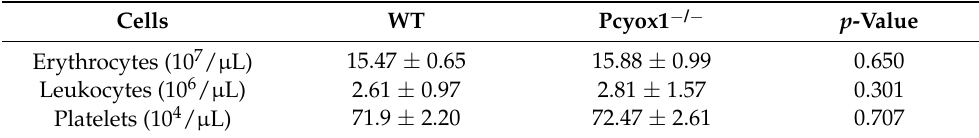
Table 1. Blood cell count in WT and Pcyox1 − / − mice. Cells WT Pcyox1 − / − p -Value Erythrocytes (10 7 / µ L) 15.47 ± 0.65 15.88 ± 0.99 0.650 Leukocytes (10 6 / µ L) 2.61 ± 0.97 2.81 ± 1.57 0.301 Platelets (10 4 / µ L) 71.9 ± 2.20 72.47 ± 2.61